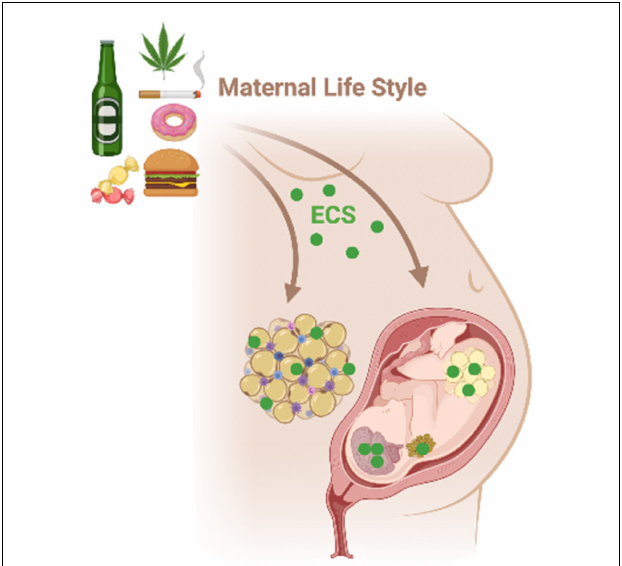
FIGURE 6 | Maternal environmental insults such as diet, smoking, and alcohol consumption during critical periods of life, as gestation, may affect the ECS in the hypothalamus-adipose axis of the mother and the progeny. The ECS disruption during early life can program metabolism in a short- and long-term way increasing the risk to develop metabolic syndrome and behavioral changes throughout